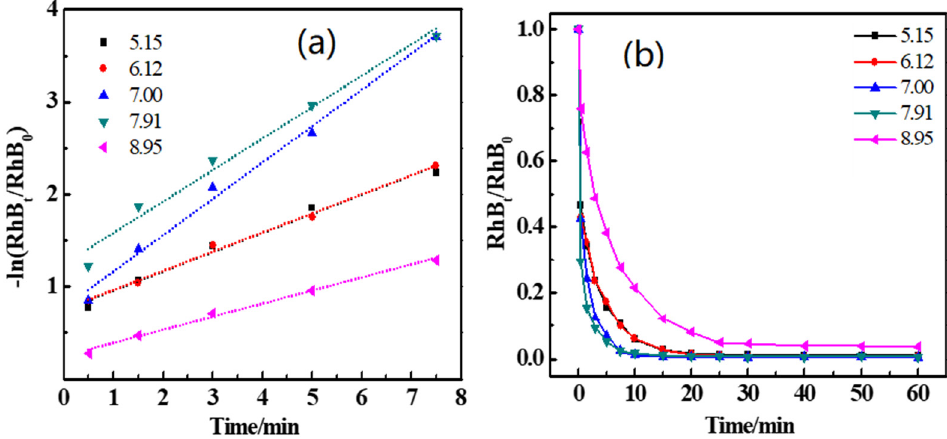
Figure 9. Catalytic degradation of RhB under different pH conditions ( a ) plots of pseudo-first-order kinetics; ( b ) RhB concentration.